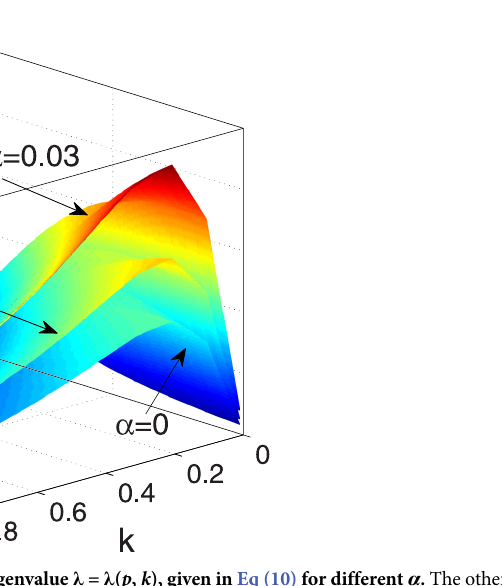
Fig 4. An illustration of imaginary values of eigenvalue λ = λ ( p , k ), given in Eq (10) for different α . The other parameter values are v = 182.5, δ = 0.45.